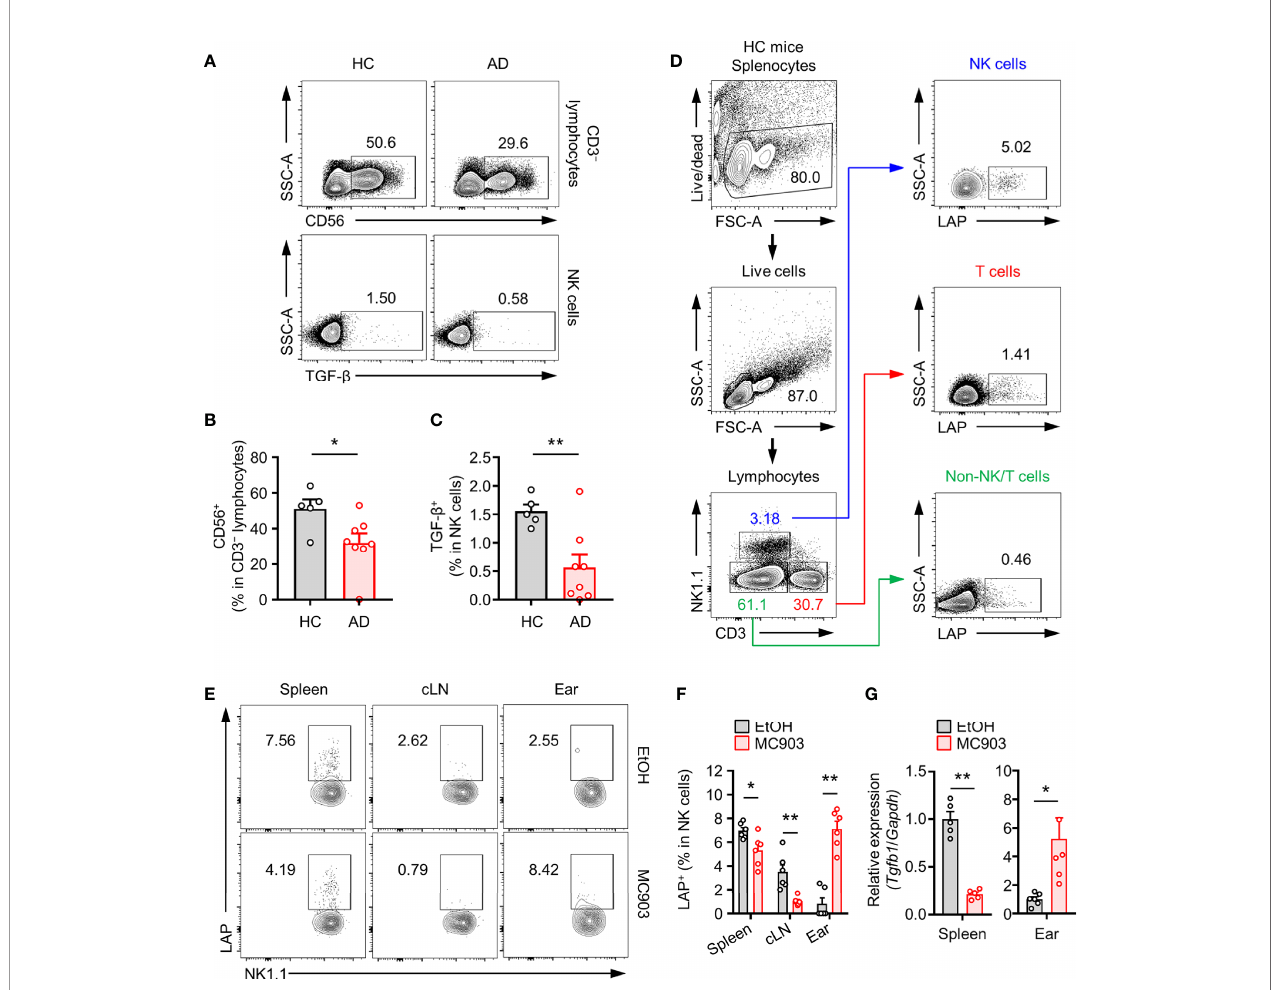
FIGURE 1 | Population changes of TGF- b + NK cells in an atopic dermatitis model. (A) Representative plot images showing TGF- b + CD56 + CD3 – PBMCs from healthy controls (n = 5) or atopic dermatitis patients (n = 8). (B) Histograms showing frequencies of total NK cells and (C) TGF- b + NK cells for panel (A) . (D) Representative fl ow cytometry images showing TGF- b + leukocytes (NK cells, T cells, and Non-T/NK cells) in mouse spleen tissues. (E) Representative plot images showing LAP (latent TGF- b ) + NK cells in spleen, cLN, ear tissues from AD mouse model. (F) Histograms showing frequencies of TGF- b + NK cells for panel E (n = 6). (G) Histograms showing gene expression of TGF- b isolated from splenic (n = 5) or ear (n = 6) NK cells. All values represent the mean ± SEM. * p < 0.05; ** p <